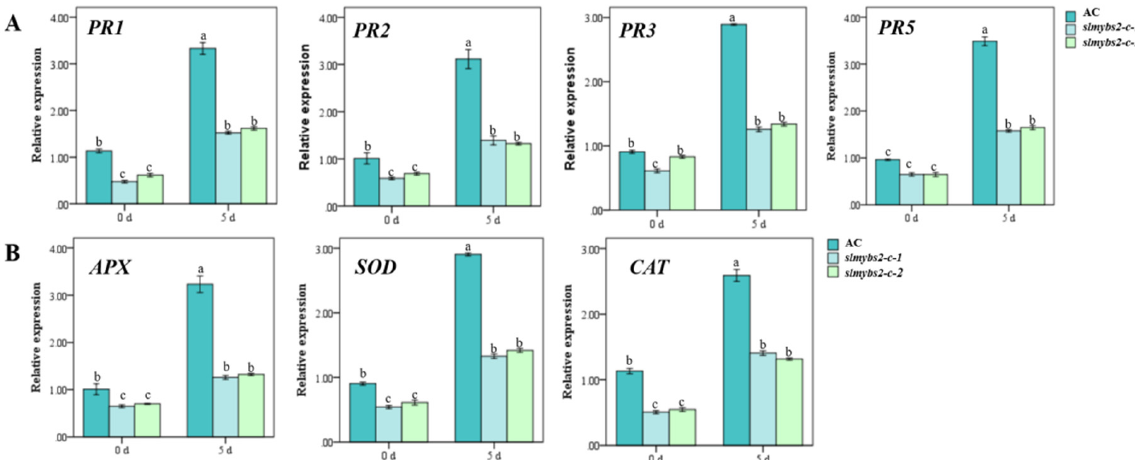
Figure 5. Accumulation of H 2 O 2 ( A ) and O 2 − ( B ) in AC and slmybs2-c -plants after inoculation with P. infestans. ( A ) Accumulation of H 2 O 2 . Tomato leaves were stained with DAB at 0, 3, and 5 dpi. ( B ) Accumulation of O 2 − in tomato leaves stained with NBT at 0, 3, and 5 dpi.